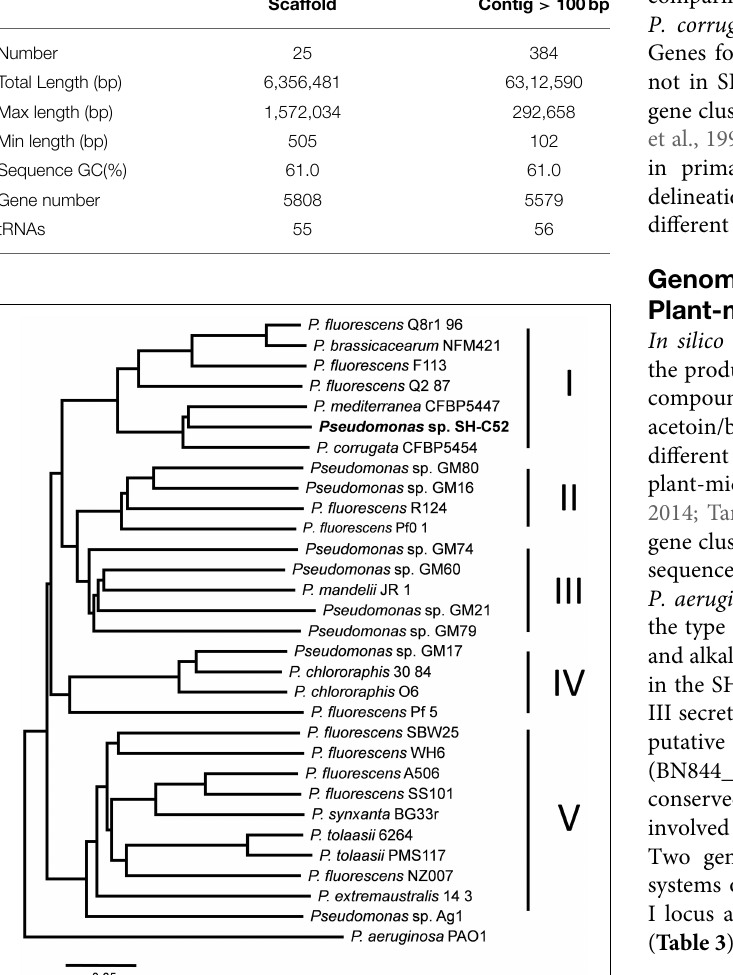
those known for the P. fluorescens clade (Loper et al., 2012).